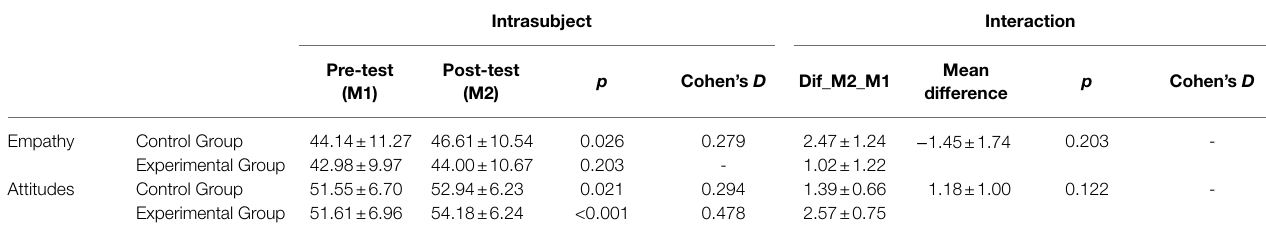
TABLE 4 | Comparative analysis of the means for the pre- and post-test variables Empathy and Attitudes in the control and experimental